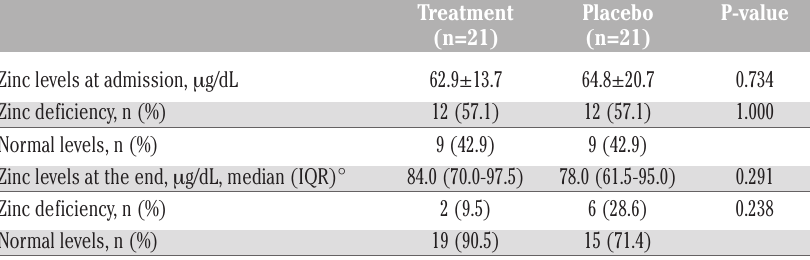
Table 3. Serum zinc levels of the children with acute asthma exacerbation in the